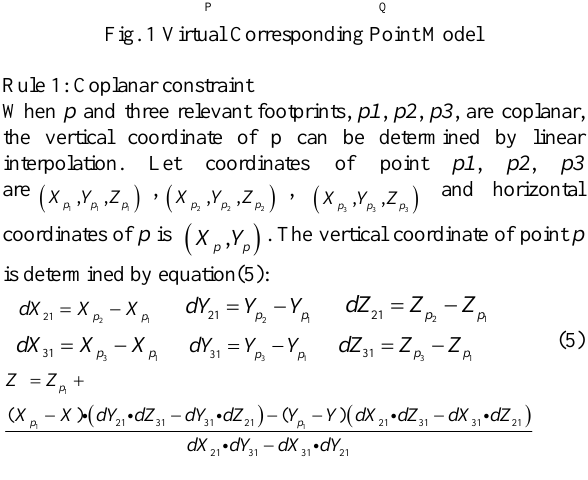
Rule 2: Rigid-body assumption According to equation(1), the modification of mounting parameters will vary footprints coordinates, furthermore affect corresponding point coordinates. Because p and p1 , p2 , p3 locate in a small area, when footprint coordinates varying, assuming the entity deformation of VCPM P obeys rigid-body transformation. After mounting parameters modified, coordinates of corresponding point p could be recalculated by rigid transformation (Formula(6)).